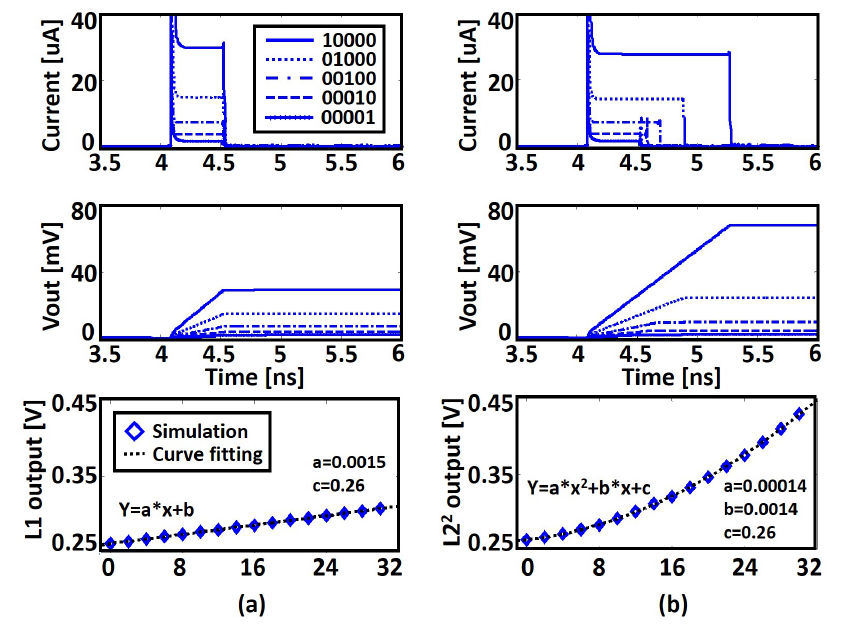
Figure 5. Current, Voltage output plots, and corresponding output curve of the proposed design for two different input sets: ( a ) integration time is fixed, current is varying; ( b ) integration time and current are both varying